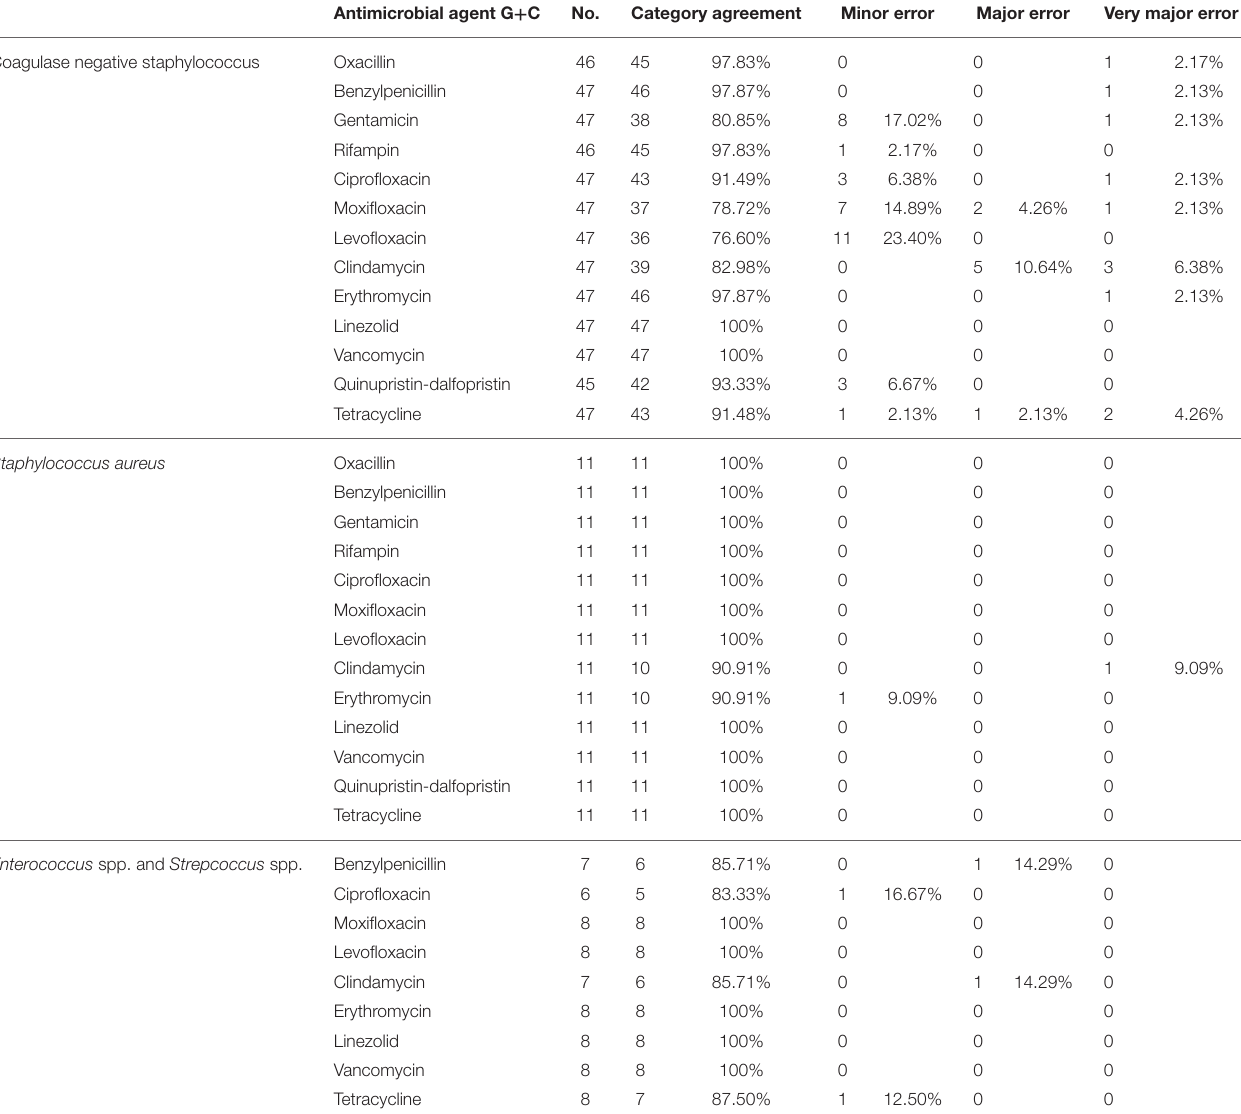
TABLE 3 | Bacterial/antimicrobial combinations and errors in gram-postive bacteria isolates from positive blood cultures. Antimicrobial agent G + C